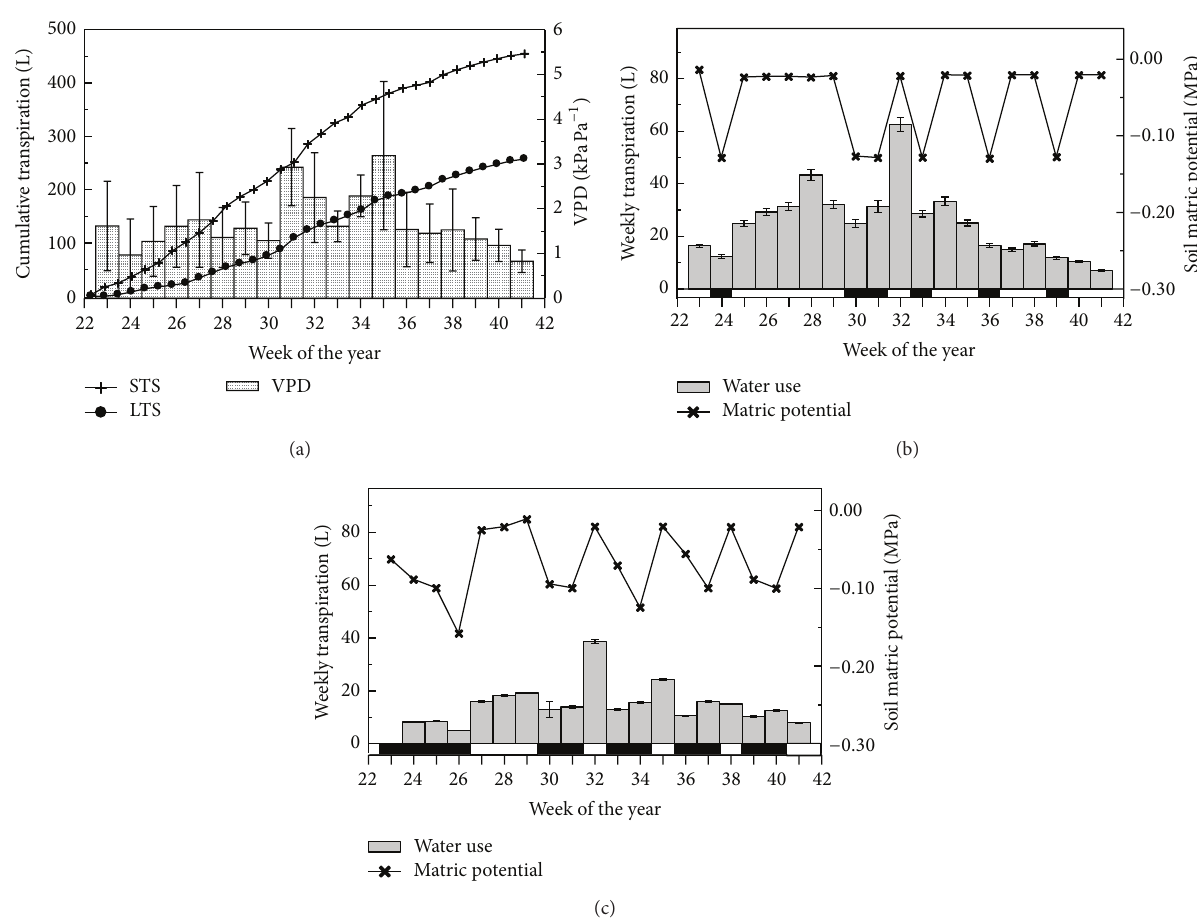
Figure 5: (a) Mean and standard deviation of the weekly vapor pressure deficit and cumulative water use, (b) short-term stress treatment mean and standard deviation of the weekly water use and mean of the soil matric potential, and (c) long-term stress treatment mean and standard deviation of the weekly water use and mean of the soil matric potential. ∗ Drought stress periods are marked with a black rectangle beneath the